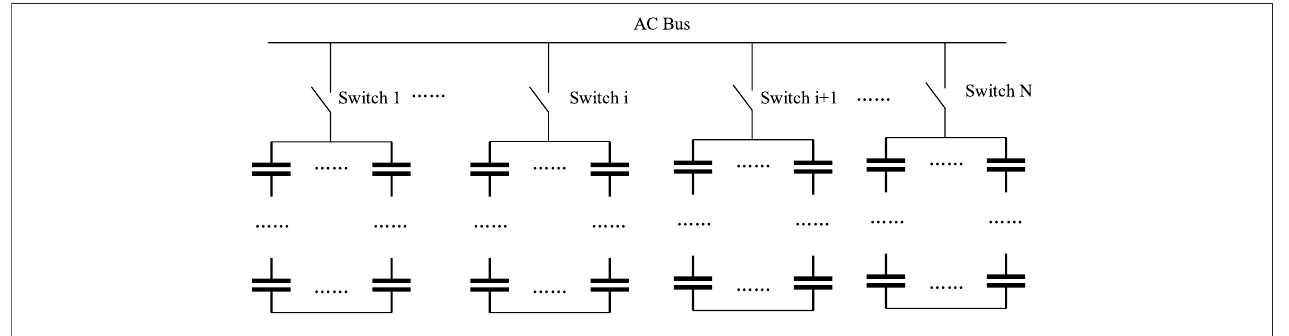
FIGURE 2 | Structure of the CBs.